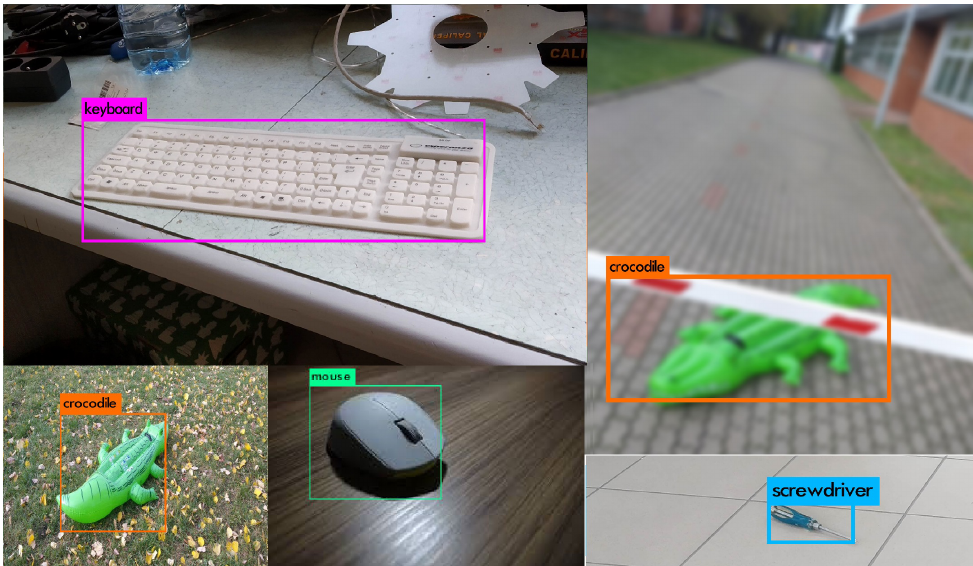
Figure 12. Examples of correct detections.